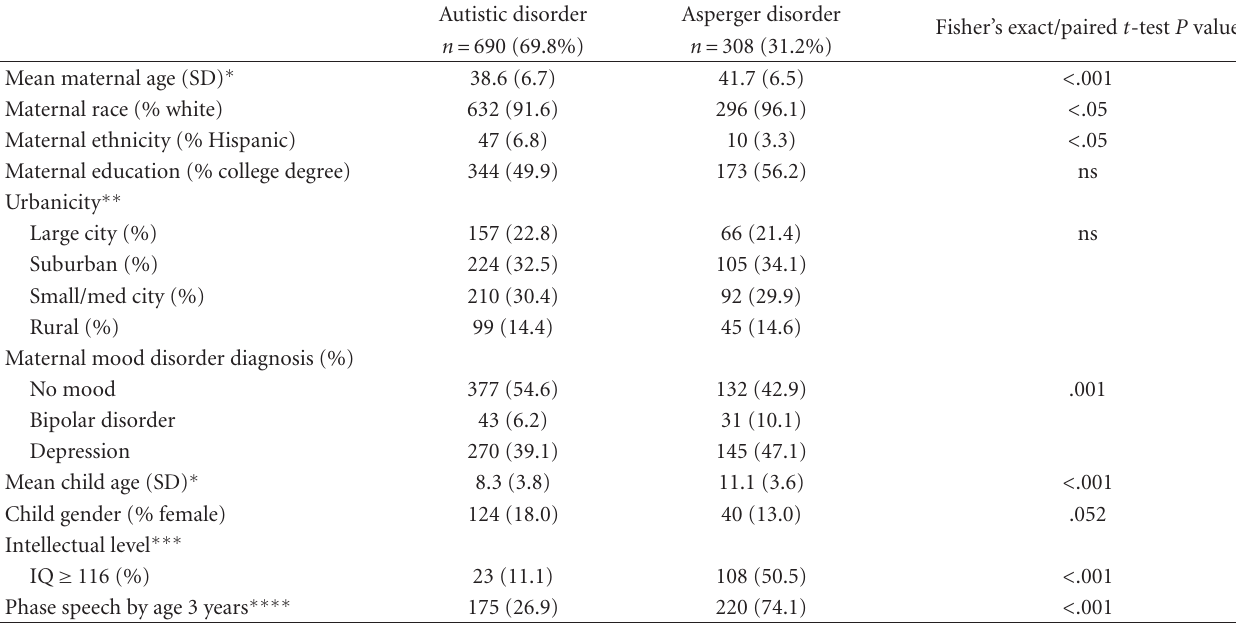
Table 1: Demographic and clinical characteristics of the final study sample of maternal-child dyads after all exclusions were applied ( n =